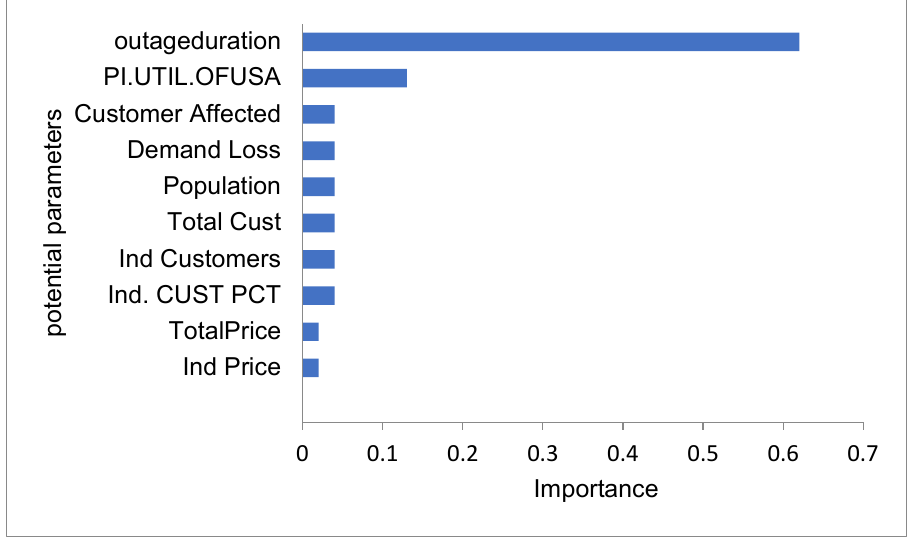
Figure 10. Ranking of the top 10 important parameters for revenue loss prediction for the hurricanes disaster category.